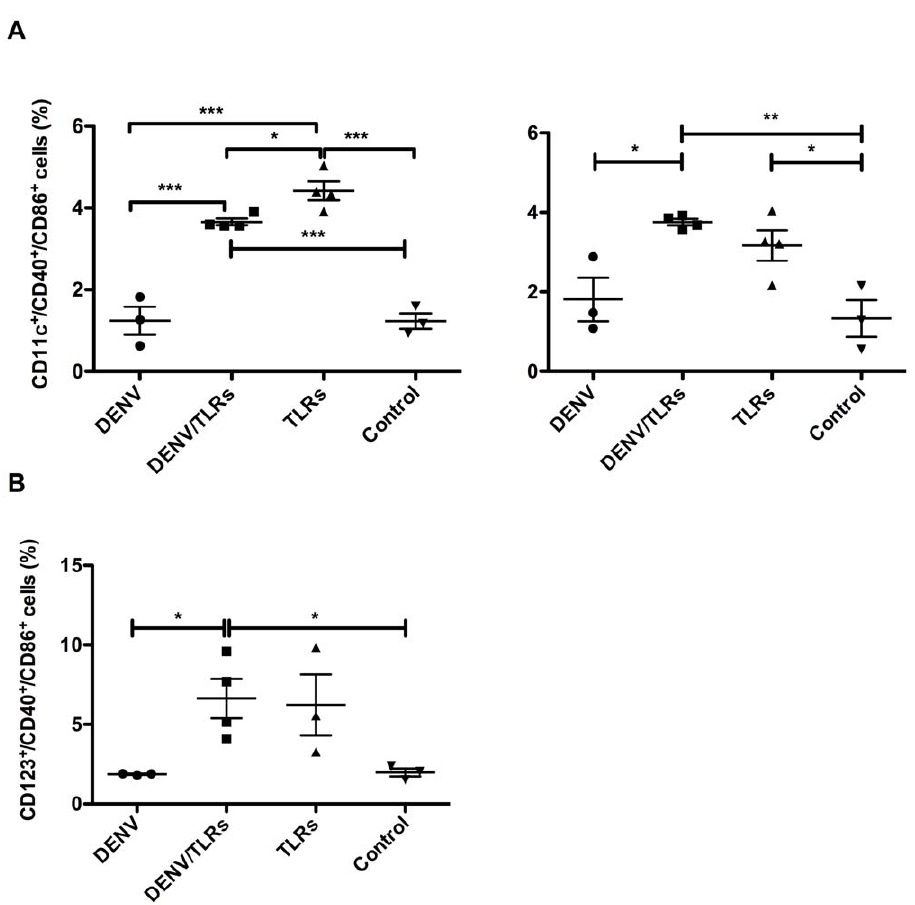
Figure 2. Dengue virus inhibits TLR-induced activation of mDC. A: Left panel, 48 hours after the first TLR stimulation, mDC were activated in the groups receiving TLRs but not in the group receiving only the virus. Coincident with the peak of viremia at day 4, an inhibitory effect of DENV on the mDC subset was evidenced by the frequency of activated cells in the DENV group, which was significantly lower compared to the DENV/TLR and TLR groups. Right panel, 10 days after the infection (72 hours after second TLR stimulation) the mDC subset was still significantly activated in both groups that received TLRs when compared to the Control group. However, the inhibitory effect of DENV was absent as there were no significant differences between the DENV and DENV/TLR groups, supporting the role of DENV replication in the inhibitory effect on mDC activation on day 4. B: Ten days after infection and 72 hours after the secondary TLR stimulation the frequency of activated pDC was significantly higher in the DENV/TLR and TLR groups compared to the DENV and Control groups. However, an inhibitory effect of DENV on this subset of DC was not observed. Asterisks denote significant differences, (*) p , 0.05, (**) p , 0.01, and (***) p , 0.00.